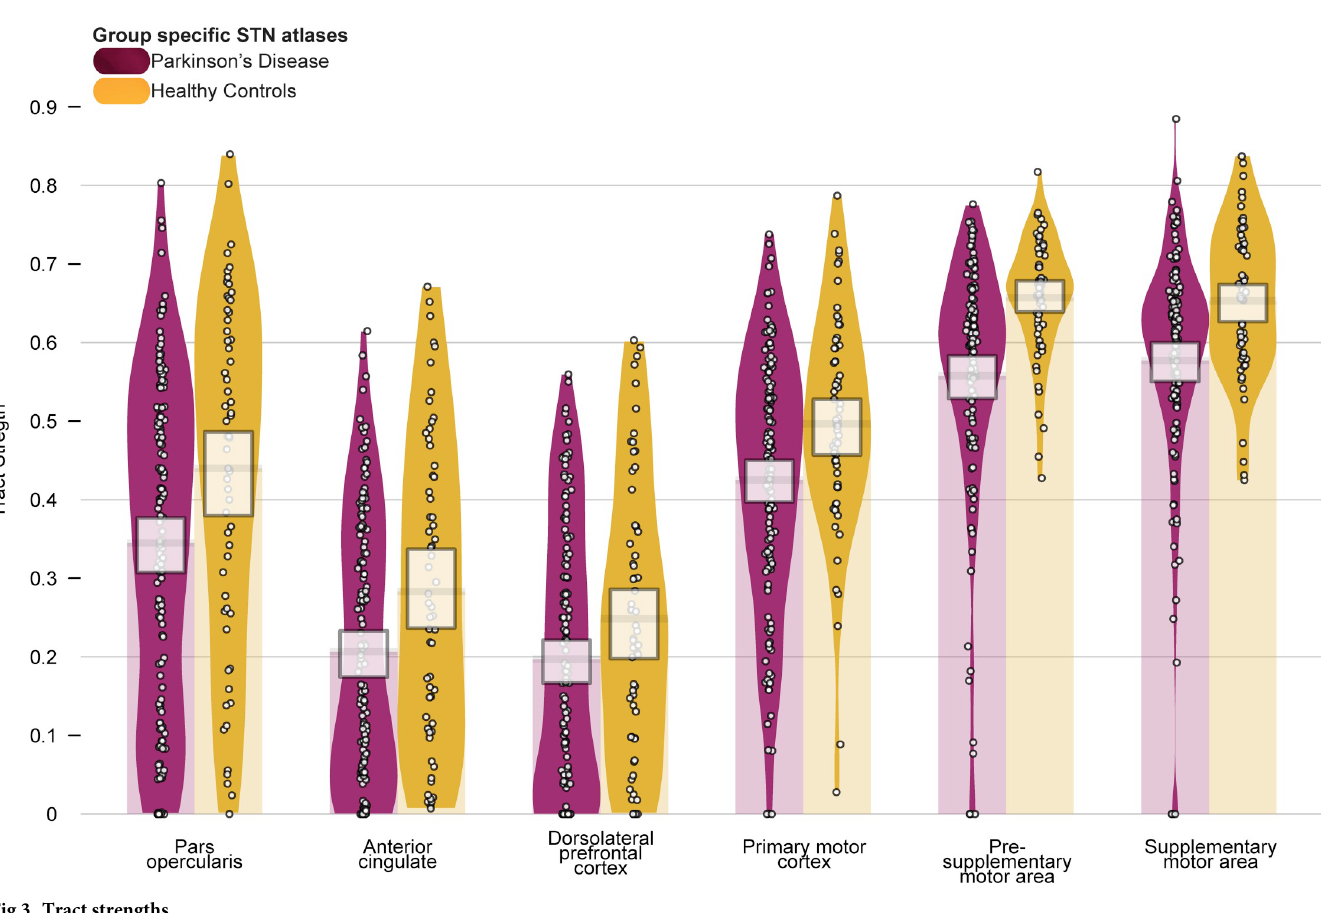
not included as a covariate in further analyses.